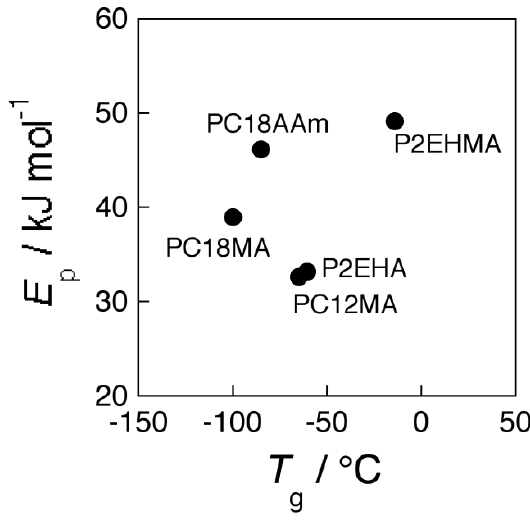
Figure 7. Relationship between activation energy of KCl transport and glass transition temperature of membrane